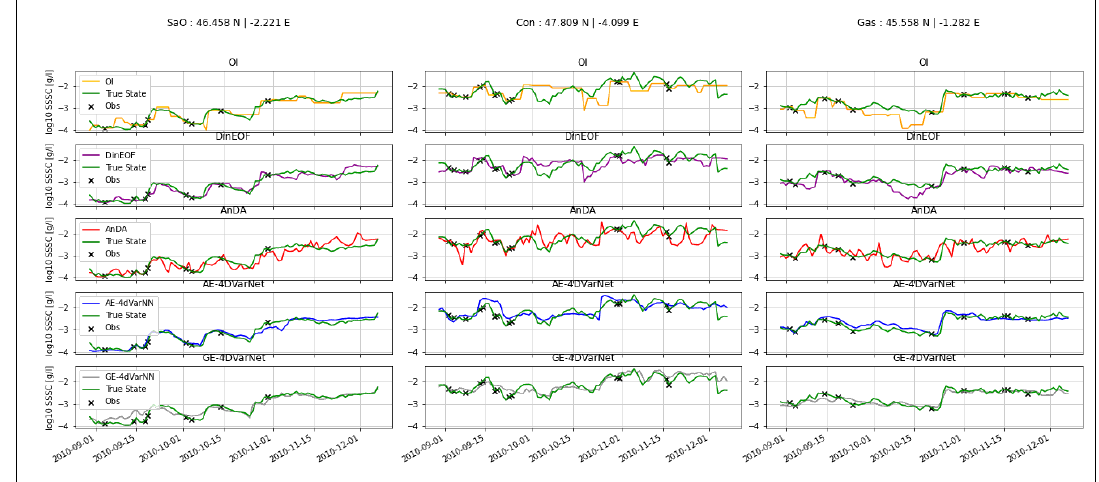
Figure 6. Time series of the SSSC reconstruction for OI, DinEOF, AnDA, AE-4DVarNet, and GE-4DVarNet. Green series refer to true state, mark to the observational term